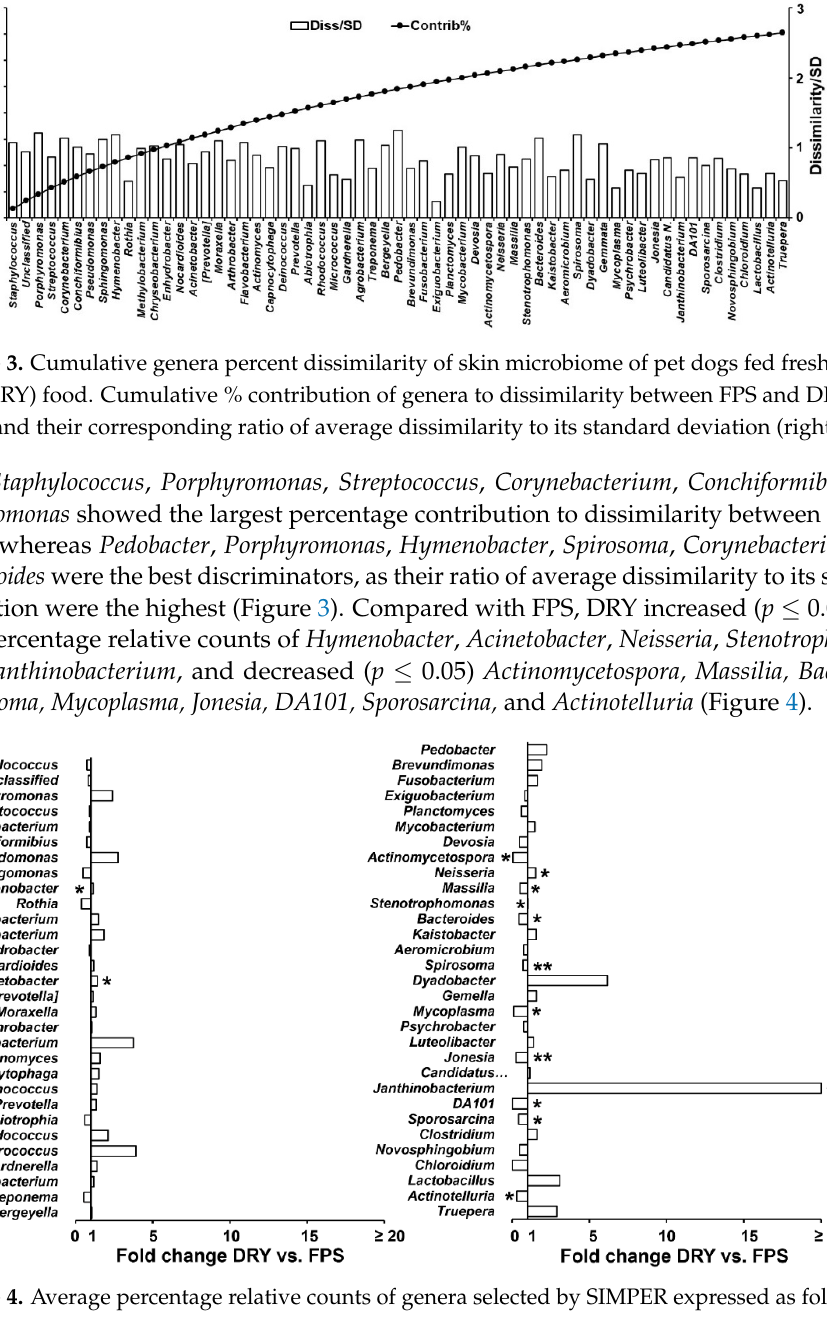
Figure 4. Average percentage relative counts of genera selected by SIMPER expressed as fold change. Dogs were fed FPS for 30 consecutive days, followed by their DRY for an additional 30 consecutive days. Data were analyzed by a one-way ANOVA that included diet as fixed effect. * p ≤ 0.05, ** p ≤ 0.01. ** p ≤